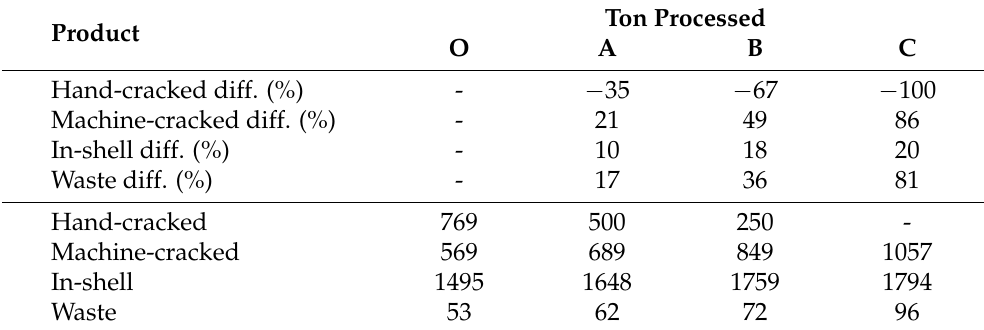
Table 8. Production levels for each hand-cracked capacity case.